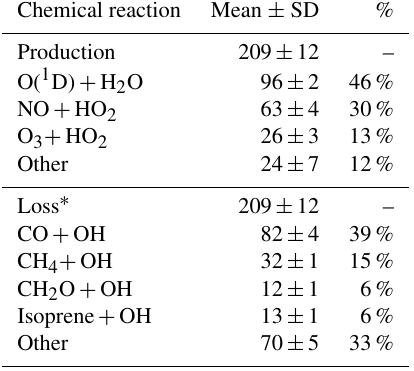
Figure 3. Anomaly of the detrended annual global total OH ten- dency from reactions O( 1 D) + H 2 O, NO + HO 2 , O 3 + HO 2 , and CO + OH. Black lines are multimodel means, and the error bars are the standard deviations of all CCMI model results. The red, blue, and grey dots and error bars show statistically significant ( P < 0.05) positive anomalies, negative anomalies, and statistically nonsignif- icant anomalies, respectively. Shaded areas represent the El Niño years with more than 5 months of MEI >